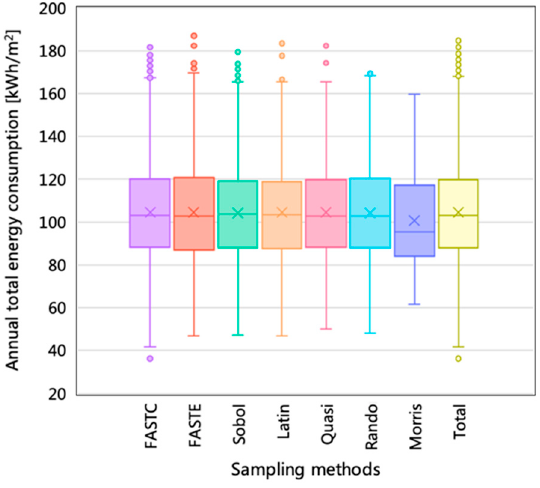
Figure 11. Simulation results of annual total building energy consumption in different sampling methods.